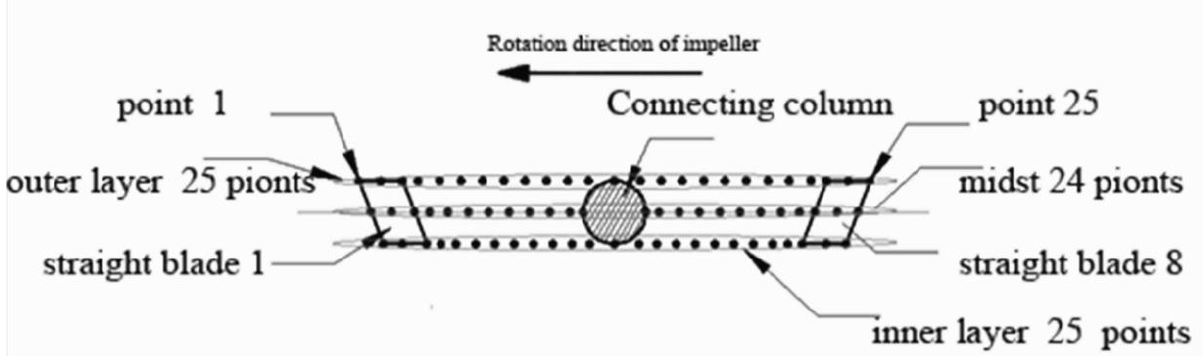
Figure 16. Distribution view of the position of radial measuring points inside the impeller.